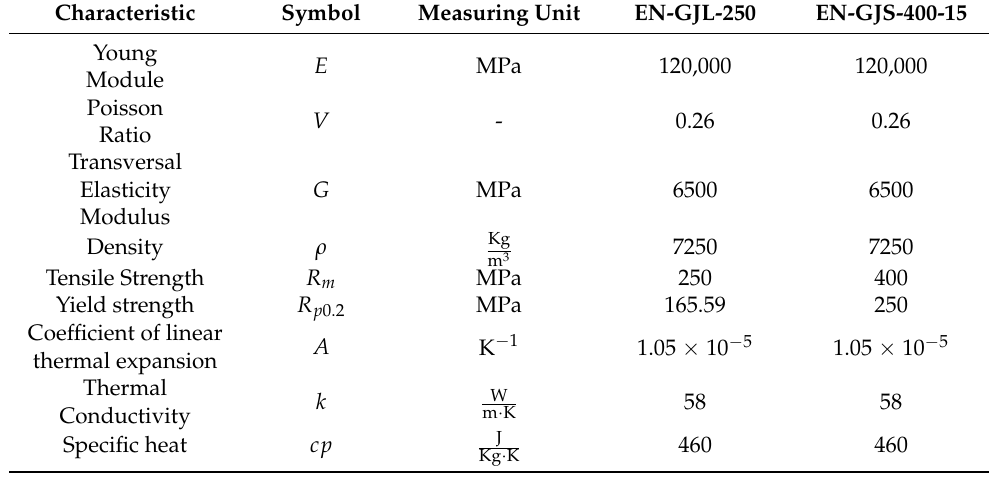
Table 3. Material characteristics of the EN-GJL-250 and EN-GJS-400-15 cast iron materials.